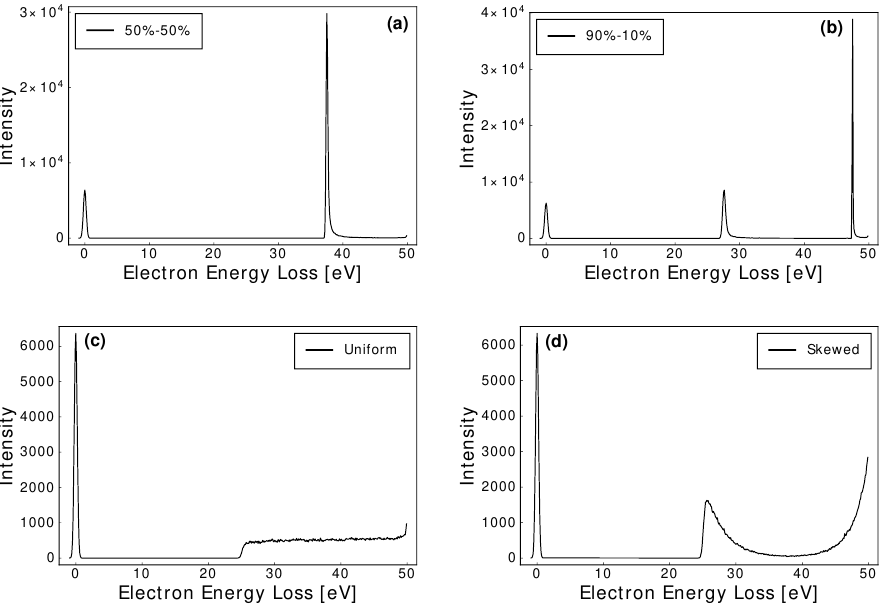
Figure A6. EELS for an elastic scattering and ionisation model. Initial energy was set to 50 eV, with an ionisation threshold of 25 eV. The energy sharing ratios, between the primary and secondary electrons, were set to 50–50% ( a ), 90–10% ( b ), uniformly randomised ( c ), and skewed randomisation in accordance to a normalised exponential cumulative distribution function ( d